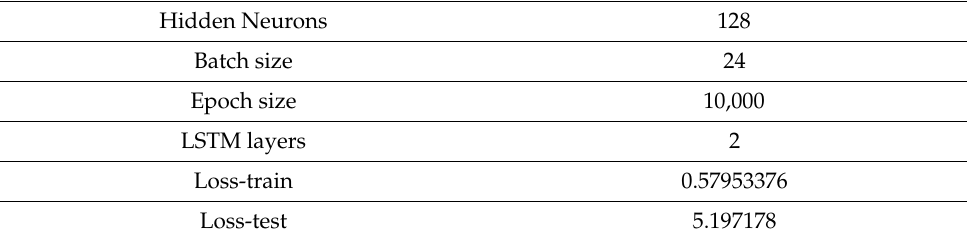
Figure 19. The training loss after optimizing model parameters. Table 4. The best parameters for the LSTM